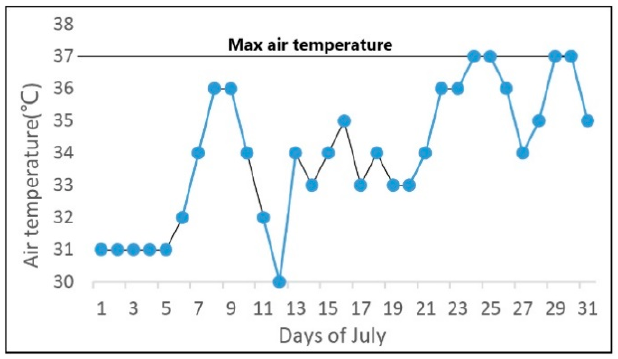
Figure 4. Daily air temperature in July 2016.